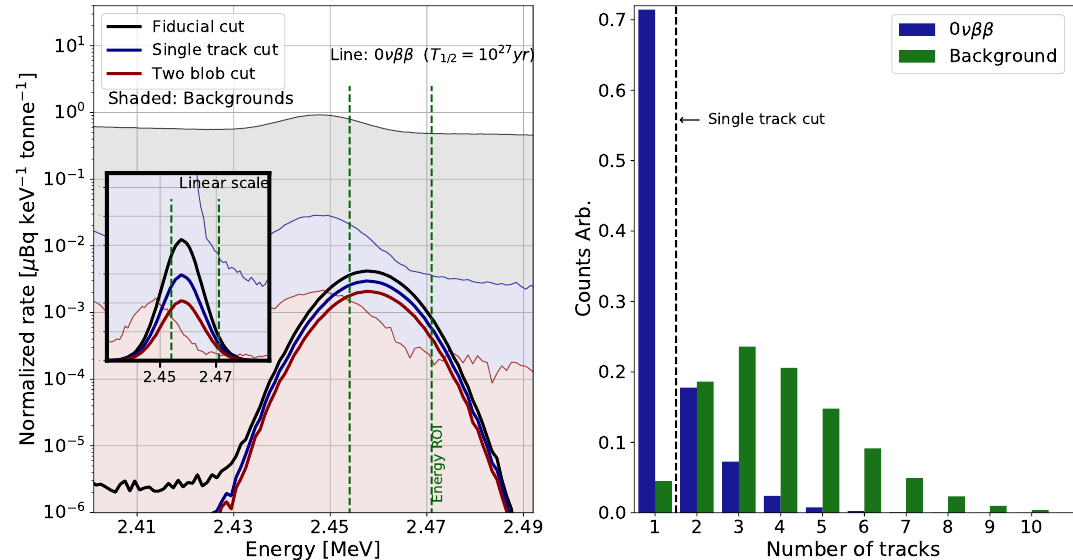
Figure 6 . Left: normalized energy spectra of all simulated events after each selection cut is applied. The shaded distributions correspond to the backgrounds events, while the 0 νββ signal (whose half- life is assumed to be 10 27 yr for illustration purposes) is represented with solid lines. Right: track multiplicity for signal (blue bars) and background (green bars)